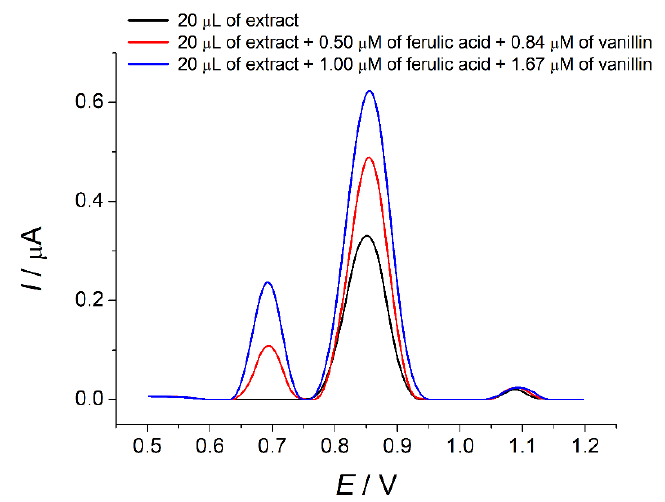
Figure 12. Baseline-corrected DPVs of Vanilla planifolia extract in the absence and in the presence of standard additions of ferulic acid and vanillin in the electrochemical cell on standard additions of ferulic acid and vanillin in the electrochemical cell on polyBCP/f-SWCNTs/GCE polyBCP/f-SWCNTs/GCE in BRB, pH 2.0. Δ Е pulse = 75 mV; t pulse = 25 ms; υ = 10 mV s ‒ 1 . in BRB, pH 2.0. ∆ E pulse = 75 mV; t pulse = 25 ms; υ = 10 mV s − 1 .